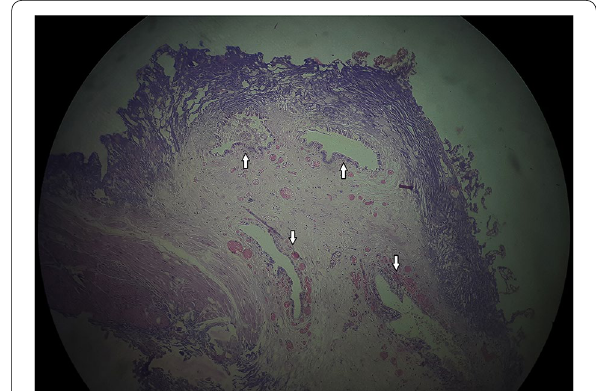
Fig. 3 Histopathological examination revealing gland-like lumens with columnar cells lining and surrounding chronic inflammatory cells infiltrate in the lamina propria (H&E,